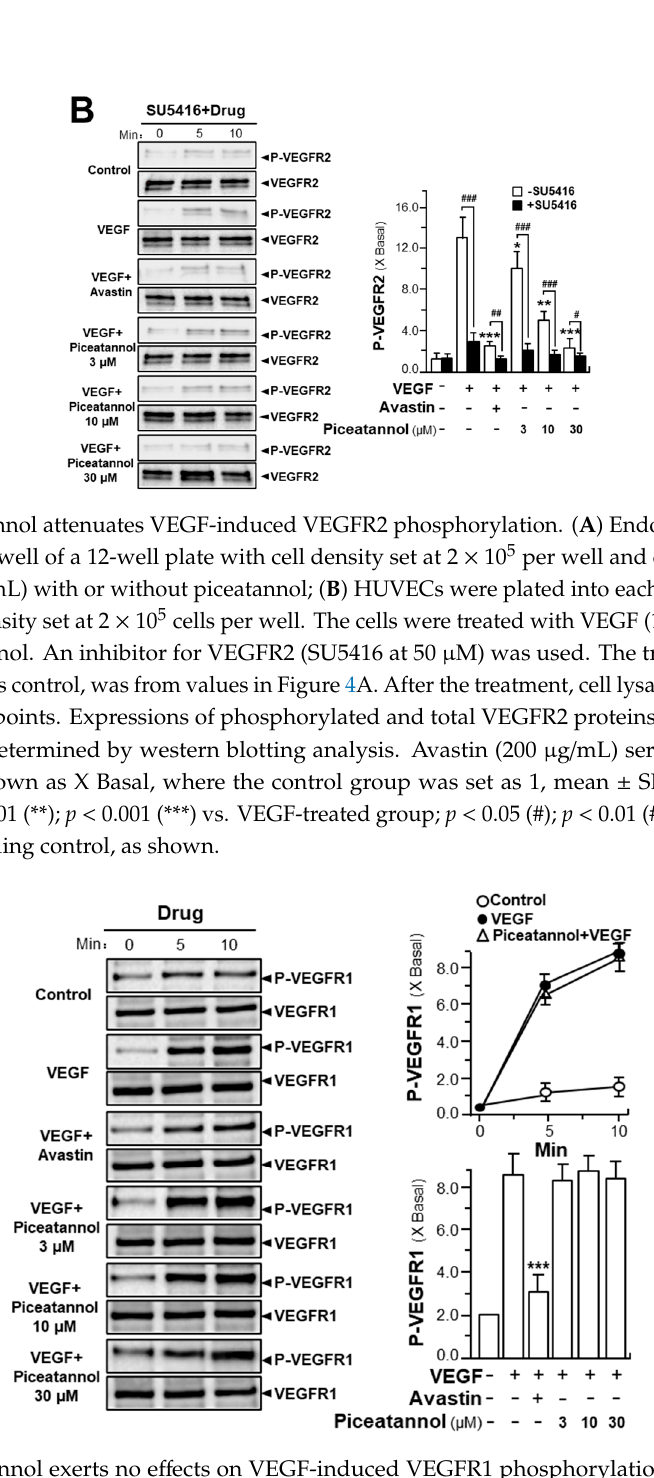
Figure 5. Piceatannol exerts no effects on VEGF-induced VEGFR1 phosphorylation. About 2 × 10 5 endothelial cells were seeded into each well of a sterile 12-well plate. VEGF, at a concentration of 10 ng/mL, was used to treat cells in the presence or absence of piceatannol. After drug treatment, cell lysates were collected from each well. The phosphorylated VEGFR1 at ~180 kDa was analyzed by western blotting analysis. Avastin (200 µg/mL) served as a positive control. Results are expressed as the fold of change than control (X Basal), where the control group (no drug) was set as 1, mean ± SEM, where n = 3; p < 0.001 (***) vs. VEGF-treated group.